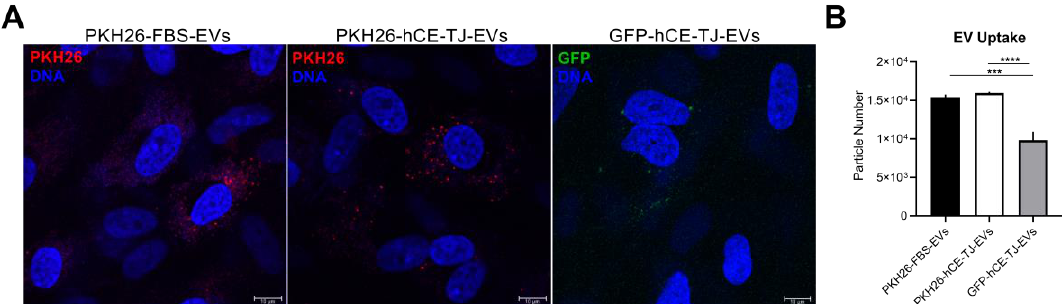
Figure 2. Uptake of EVs by human corneal fibroblasts (hCFs) in vitro occurs by 12–16 h post-application. ( A ) EVs isolated from FBS or hCE-TJ-conditioned medium were labelled with the lipophilic dye, PKH26, and applied topically to hCFs. EVs were also isolated from GFP-expressing hCE-TJ-conditioned medium and incubated with hCFs. Then, 25 µ g / mL of EVs were applied to each sample. PKH26-labelled EVs = red; GFP-labelled EVs = green; Nuclei (DNA) = blue. Scale bars = 10 µ m. ( B ) Quantification of EV uptake was performed using particle analysis in ImageJ based on the relative signal detected in the TRITC ( λ ex 550 nm, λ em 573 nm) or FITC ( λ ex 495 nm, λ em 517 nm) channel for hCFs containing PKH26- or GFP-labelled EVs, respectively. n = 6. Error bars represent SEM. *** p ≤ 0.001, **** p ≤ 0.0001 based on a one-way